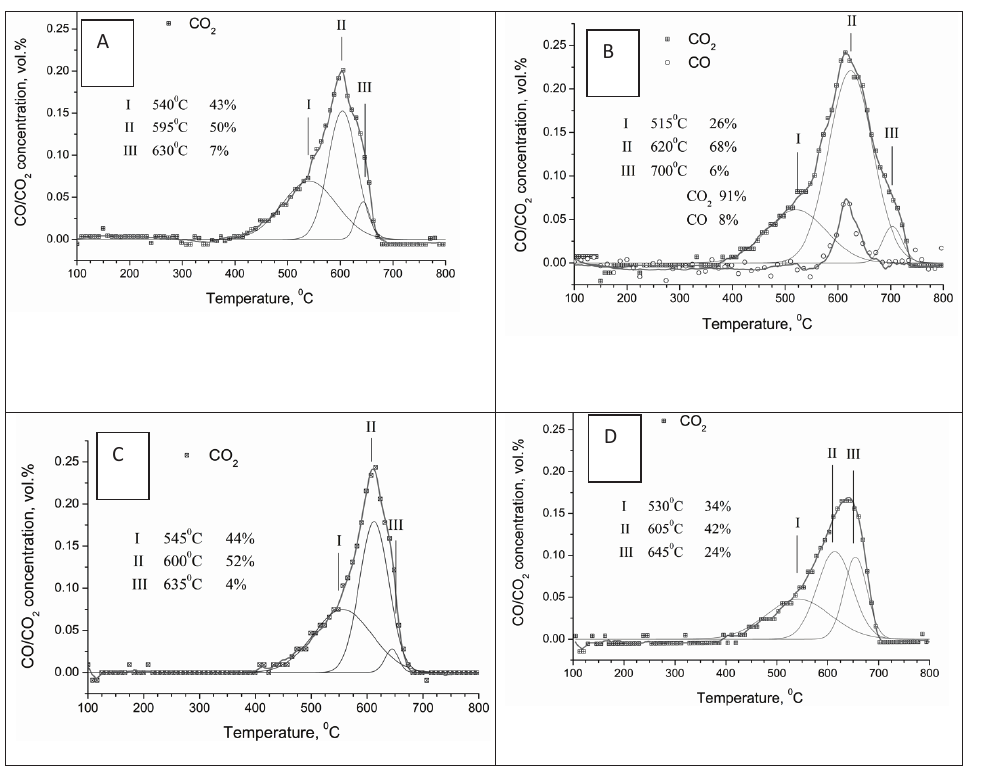
Figure 11: CO 2 production during TPO in 0.5% O 2 in He after MDR for samples Ni/B1 (A, C) and Ni/Ch (B, D) as prepared (A, B) and reduced (C, D).